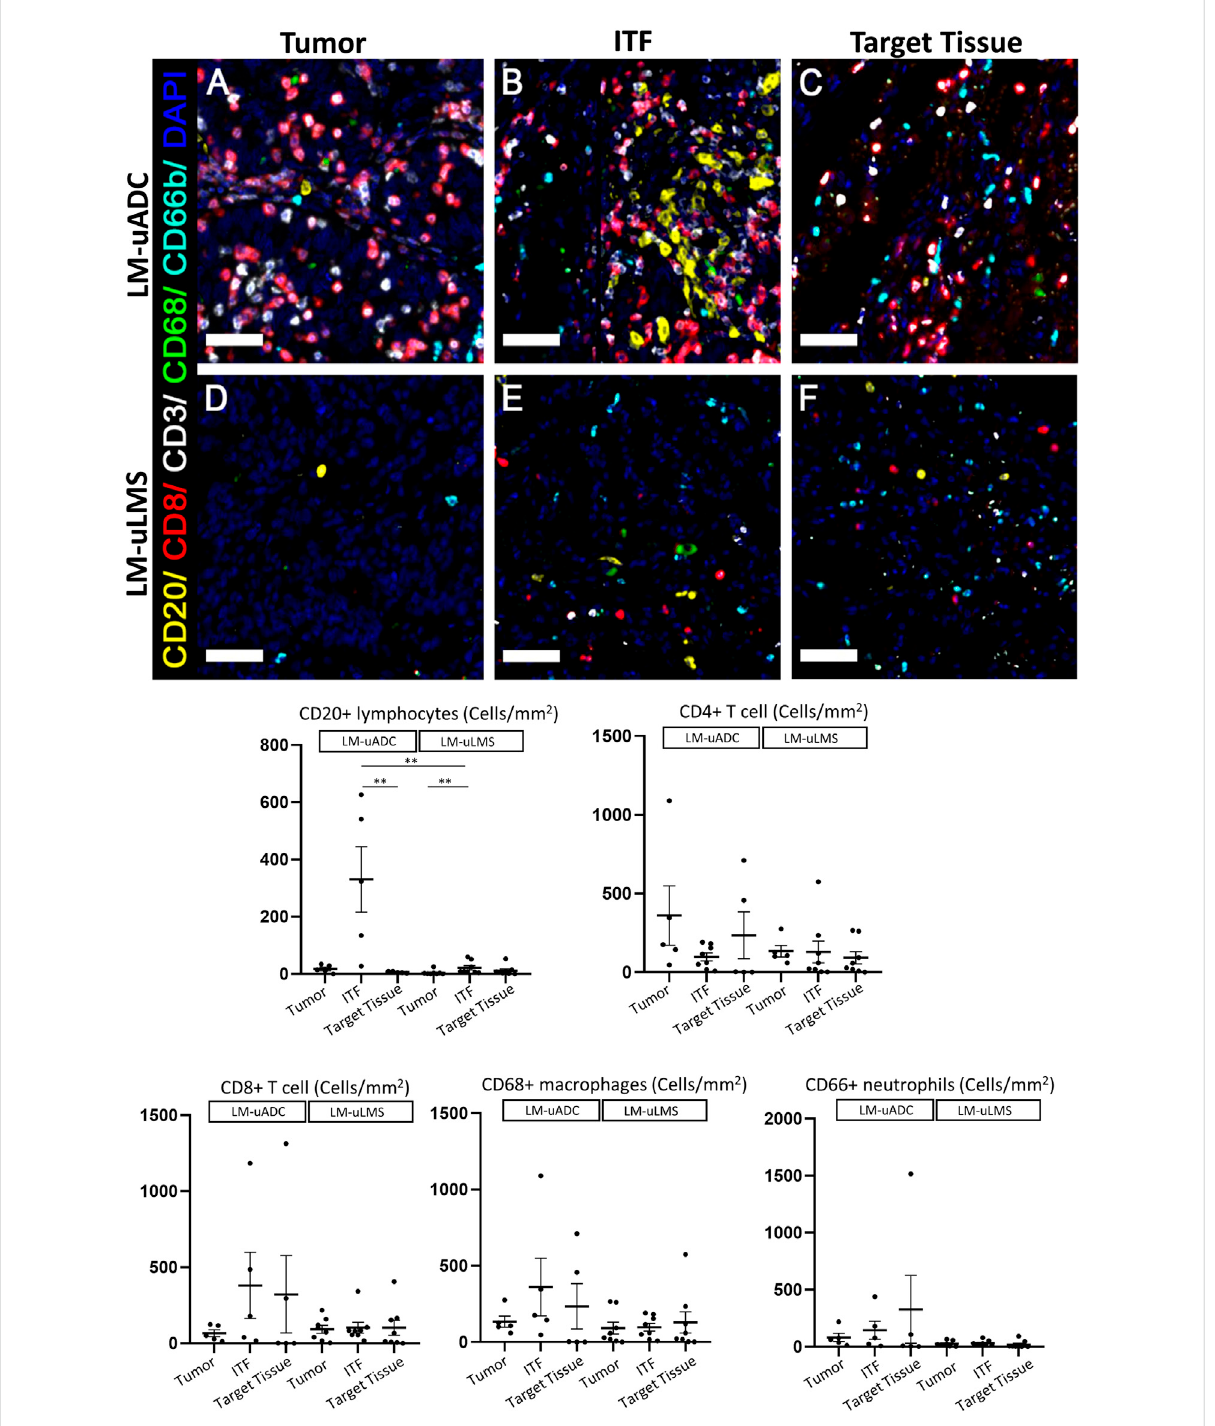
FIGURE 3 Immune in fi ltrate distribution in metastatic tumors. (A,B, and C) metastatic uterine adenocarcinoma) and (D,E, and F) metastatic uterine leiomyosarcoma). Representative multiplex immuno fl uorescence images in 1 × 1 mm ROIs in LM-uADC (A – C) and LM-uLMS (D – F) . Color code as follows: DAPI (blue), CD20 (yellow), CD68 (green), CD8 (red), CD3 (white), CD66 (cyan). Dot plots show the mean of the densities (number of cells/ mm 2 ) for each cell marker in each region for LM-uADC and LM-uLMS. p values and signi fi cance ( p < 0.05, pp < 0.01) for statistical comparison between the means of LM-uADC and LM-uLMS at the tumor area, invasive front (ITF) and lung (TT) are displayed. Scale bars represent 50 µm.